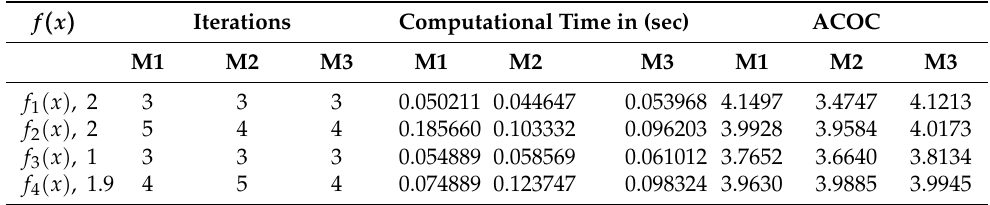
Table 2. Benchmark comparison of fourth-order methods in relation to the convergence order and computational time on the function f p x q . f ppp x